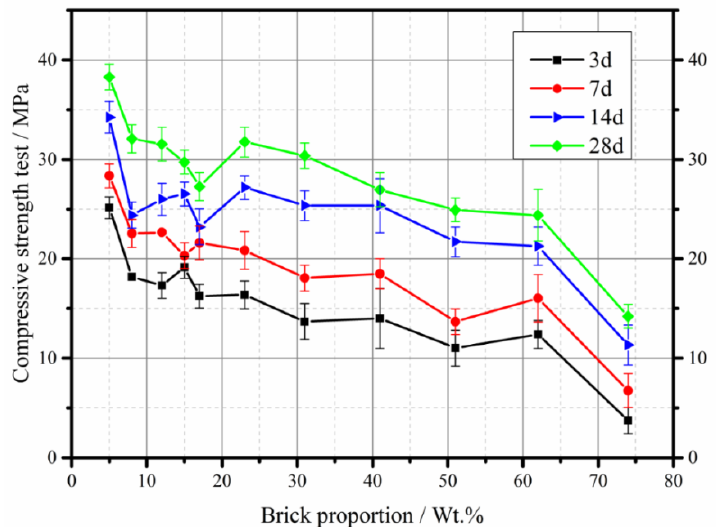
Figure 19. Compressive test of concrete mixture with different brick proportion of recycled materials.